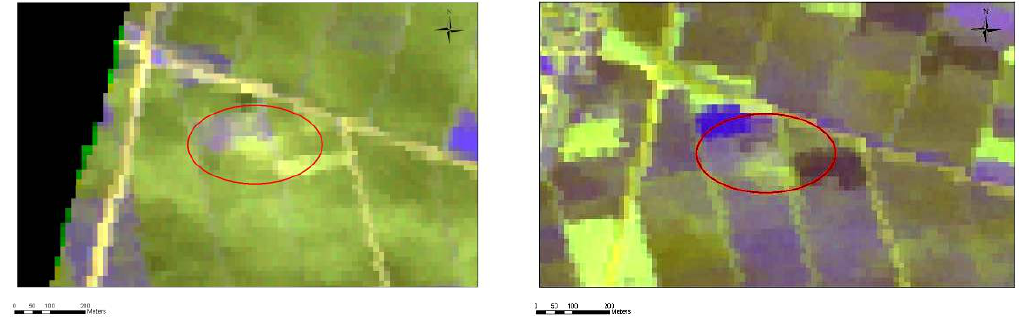
Figure 4. Appearance of the Orfana settlement on the ASTER image (RGB → 1,2,3) with acquisition date of 19-03-2003 (left). Right: Appearance of the same settlement on 30- 06- 2004 (right).